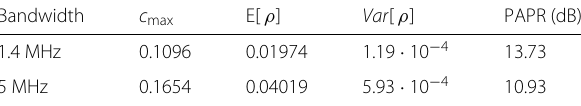
Table 1 Input envelope statistical values and